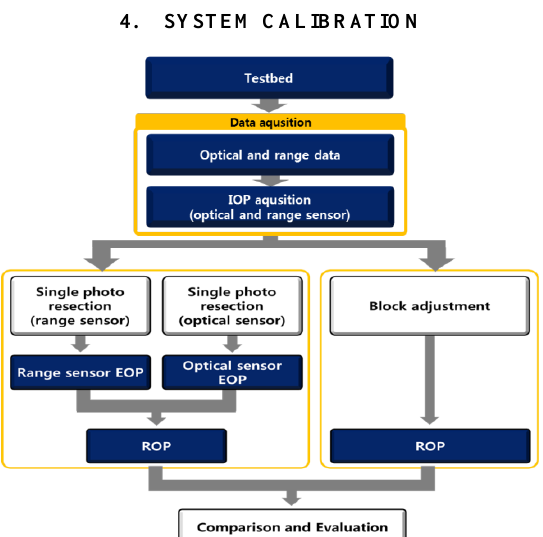
Figure 8. Flow chart of real system